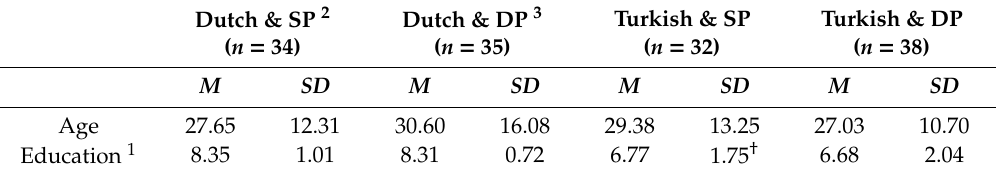
Table 3. Means and standard deviations for participants’ age and education in Study